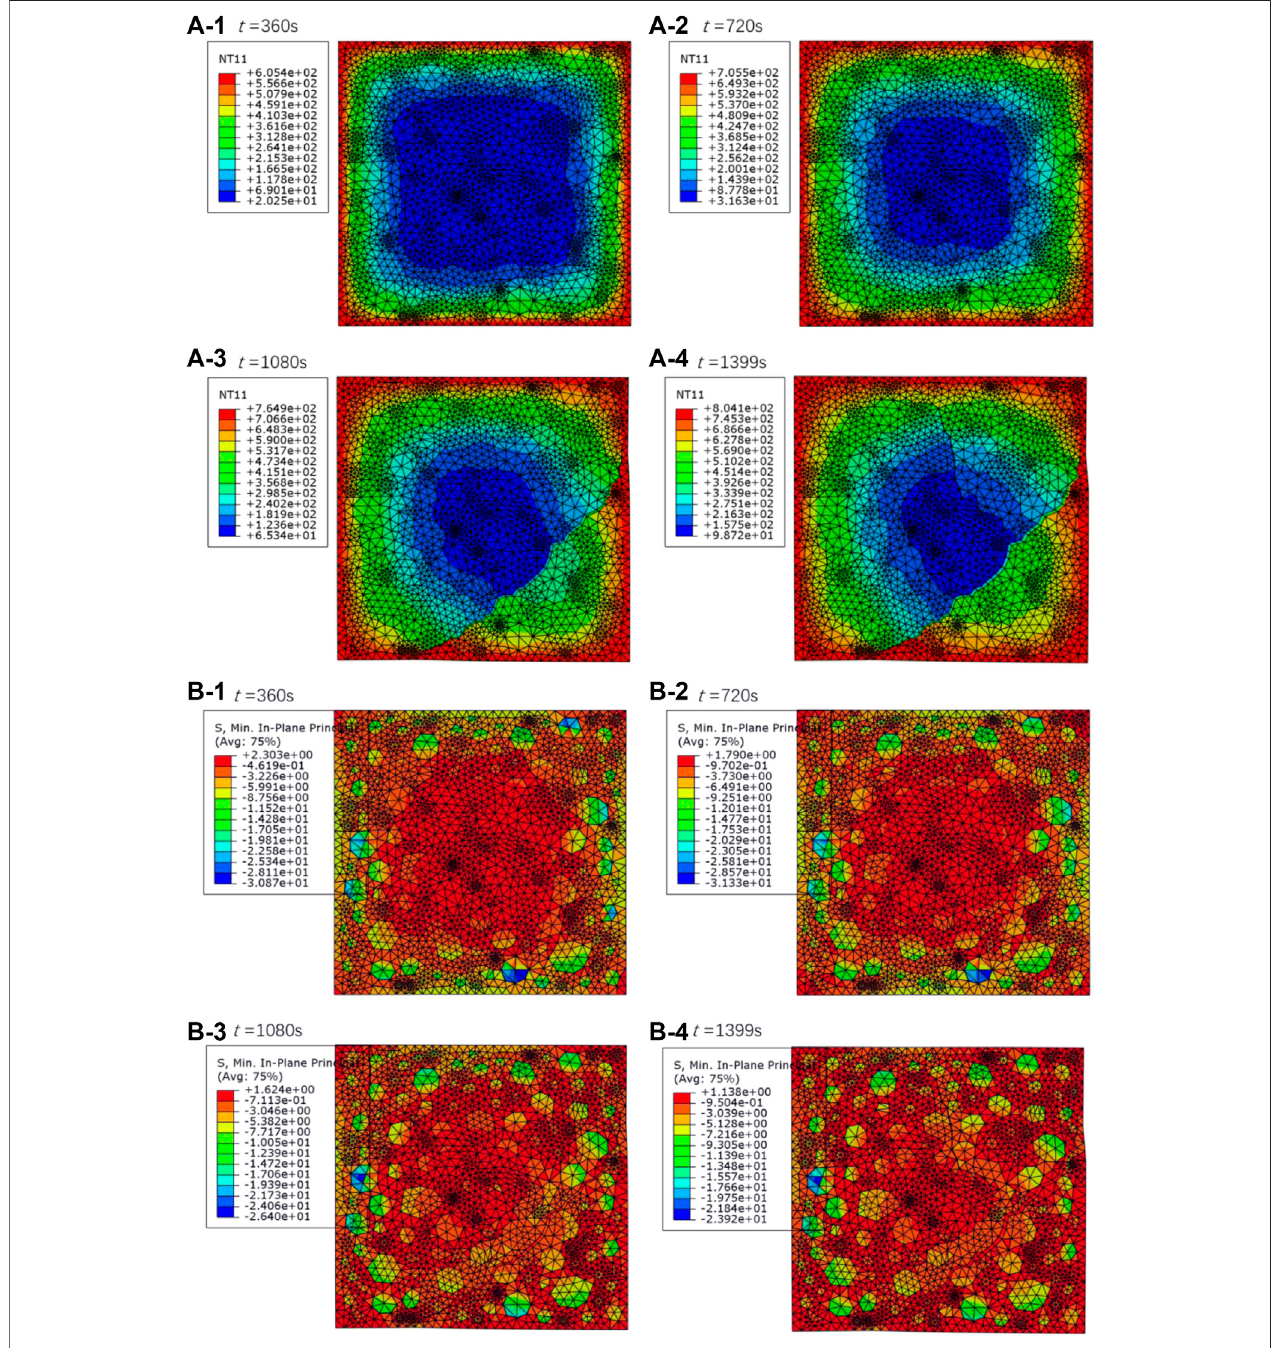
FIGURE 4 | (A) Numerical simulation results of temperature fi eld; (B) Numerical simulation results of minor principal thermal stress fi eld; (C) Numerical simulation results of major principal thermal stress fi eld.